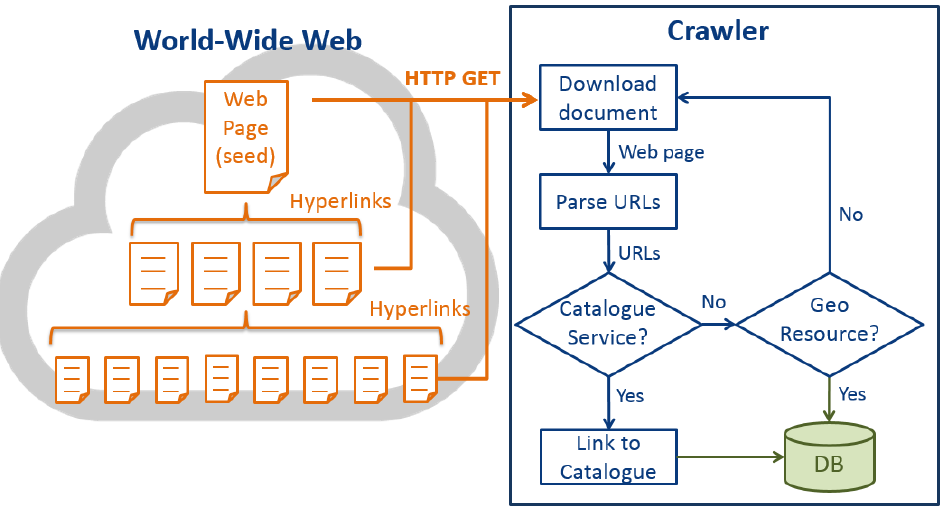
Figure 4. The architecture of the GeoWeb crawler.